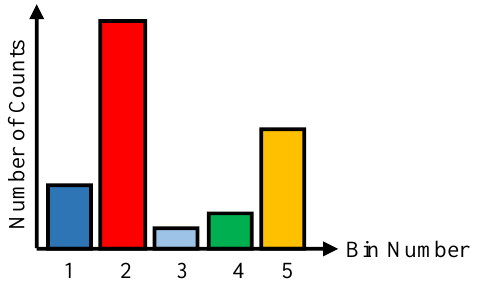
Figure 2. Code density histogram of a simple synchronous TDC with five bins.